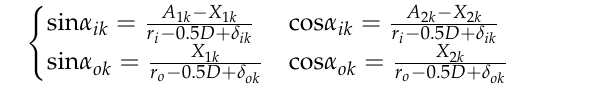
Figure 2. The geometry relations among the centers of raceway curvature and ball: ( a ) The ball con- tacts with inner raceway; ( b ) The ball separates from inner raceway.